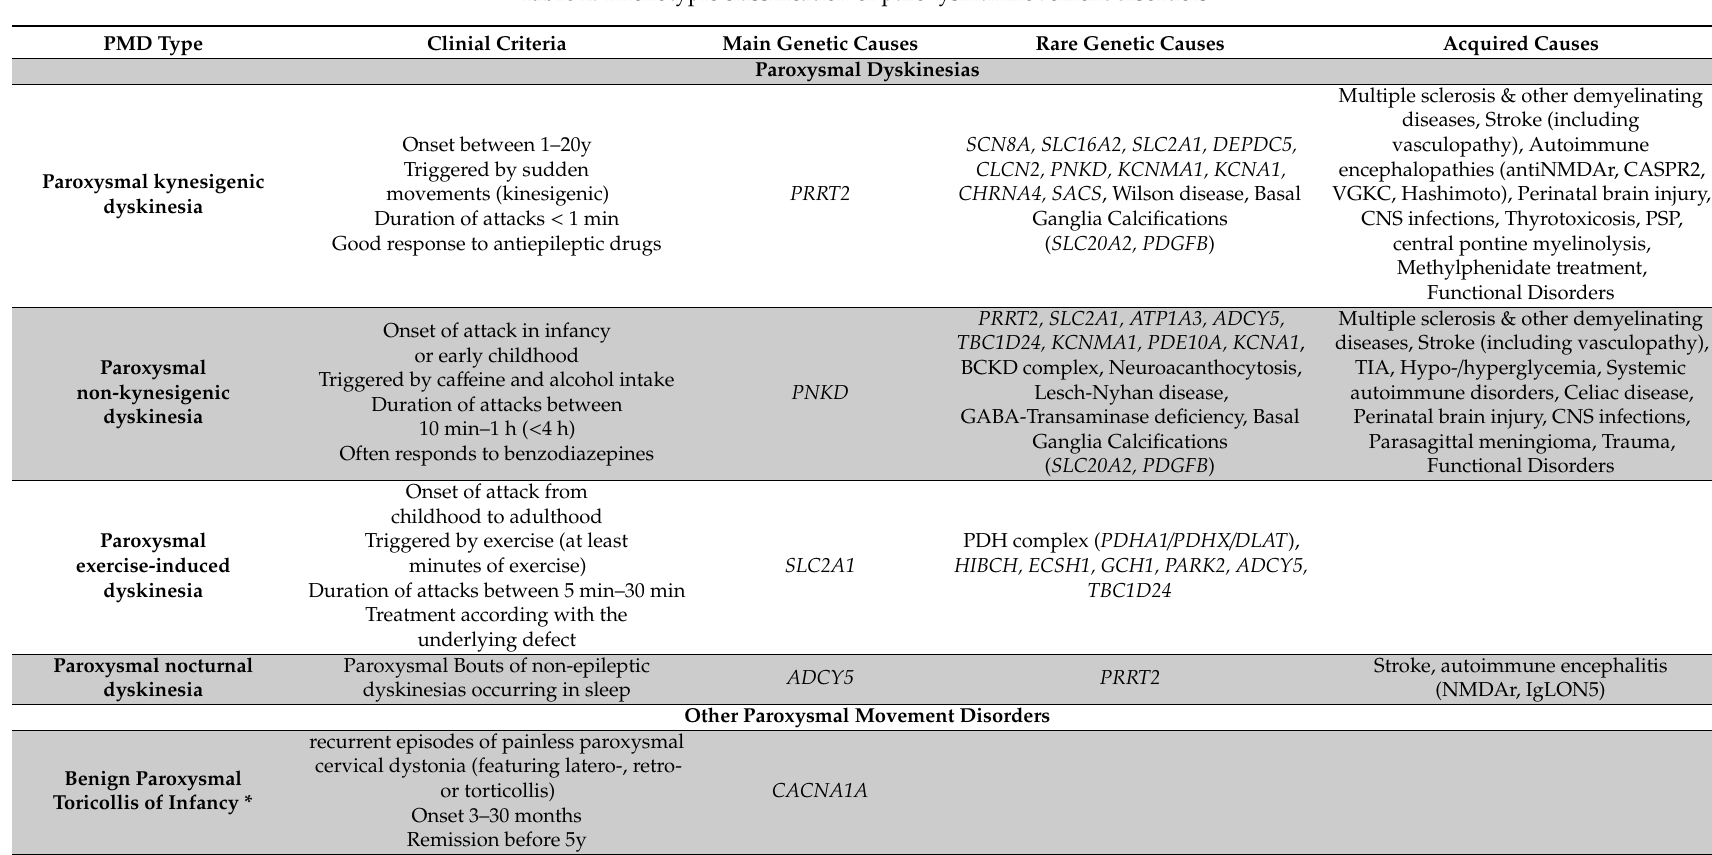
Table 2. Phenotypic classification of paroxysmal movement